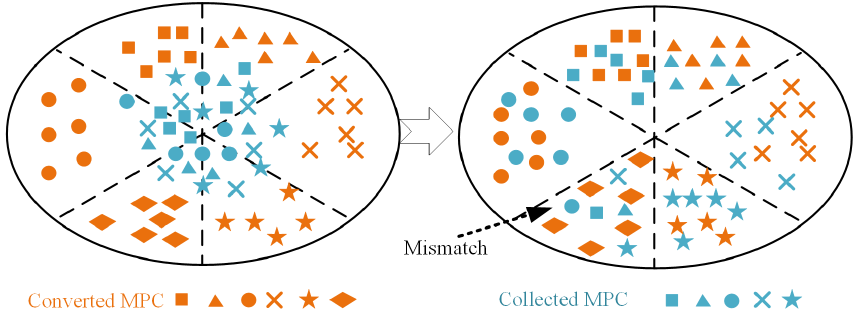
Figure 2. Illustrations of negative